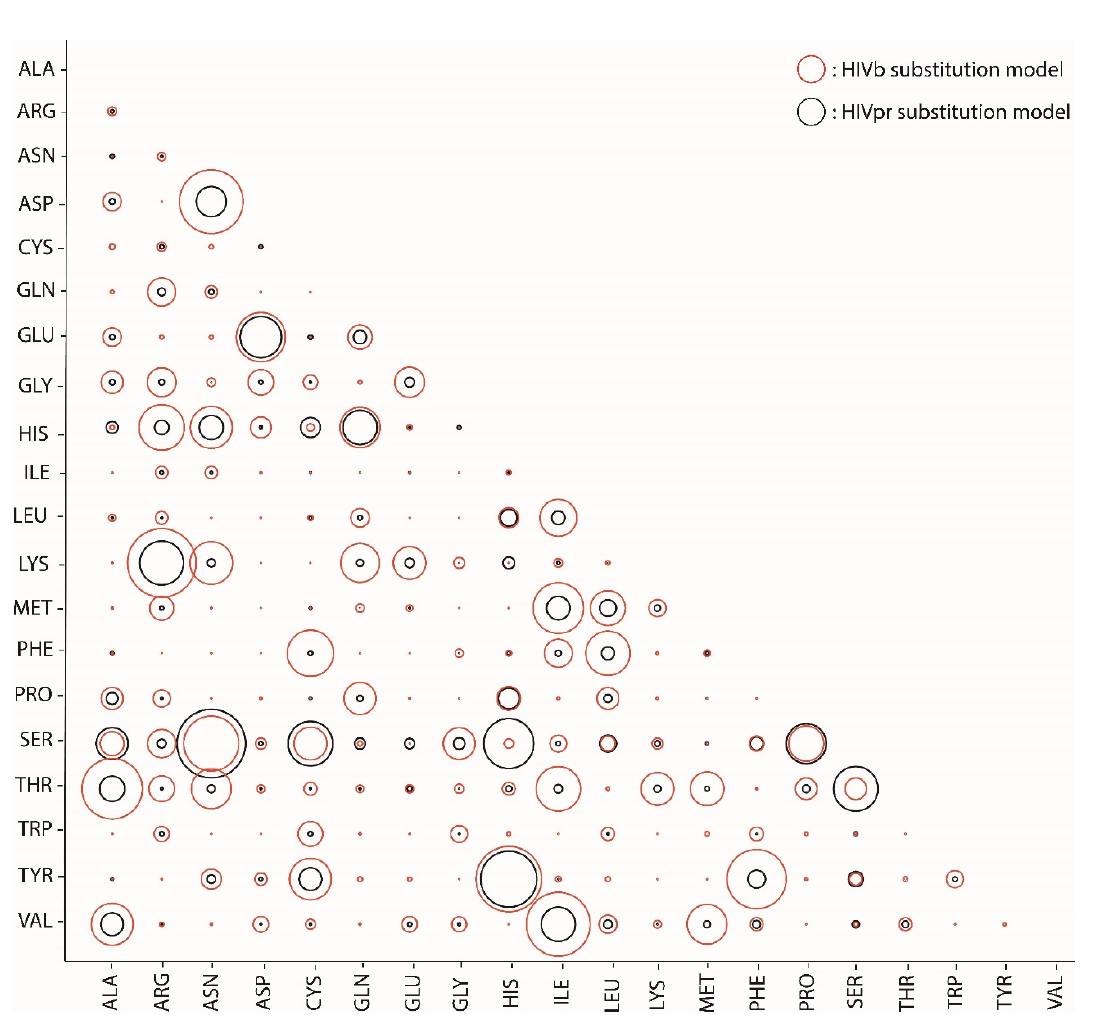
Figure 2. Comparison of HIVpr and HIVb empirical substitution models concerning their relative substitution rates. The plot displays the exchangeability matrix of the relative substitution rates among amino acids for the HIVpr (developed in this study, black circles) and HIVb (the best-fitting substitution model in the set of currently available substitution models, red circles) empirical substitution models of evolution. This plot provides an illustrative comparison between the cited models; the specific parameter values of the HIVpr substitution model are presented in Table S1.